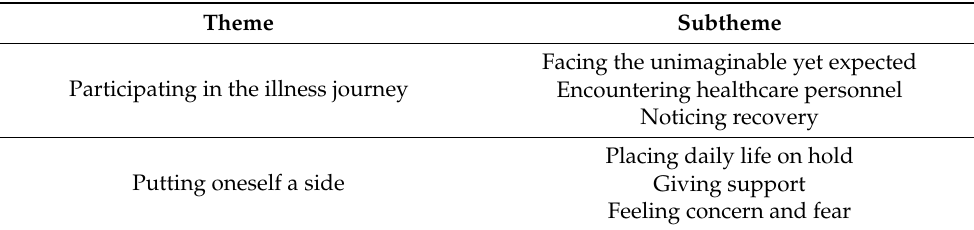
Table 2. Overview of the themes and subthemes of the interview Texts of Close Relatives ( n =